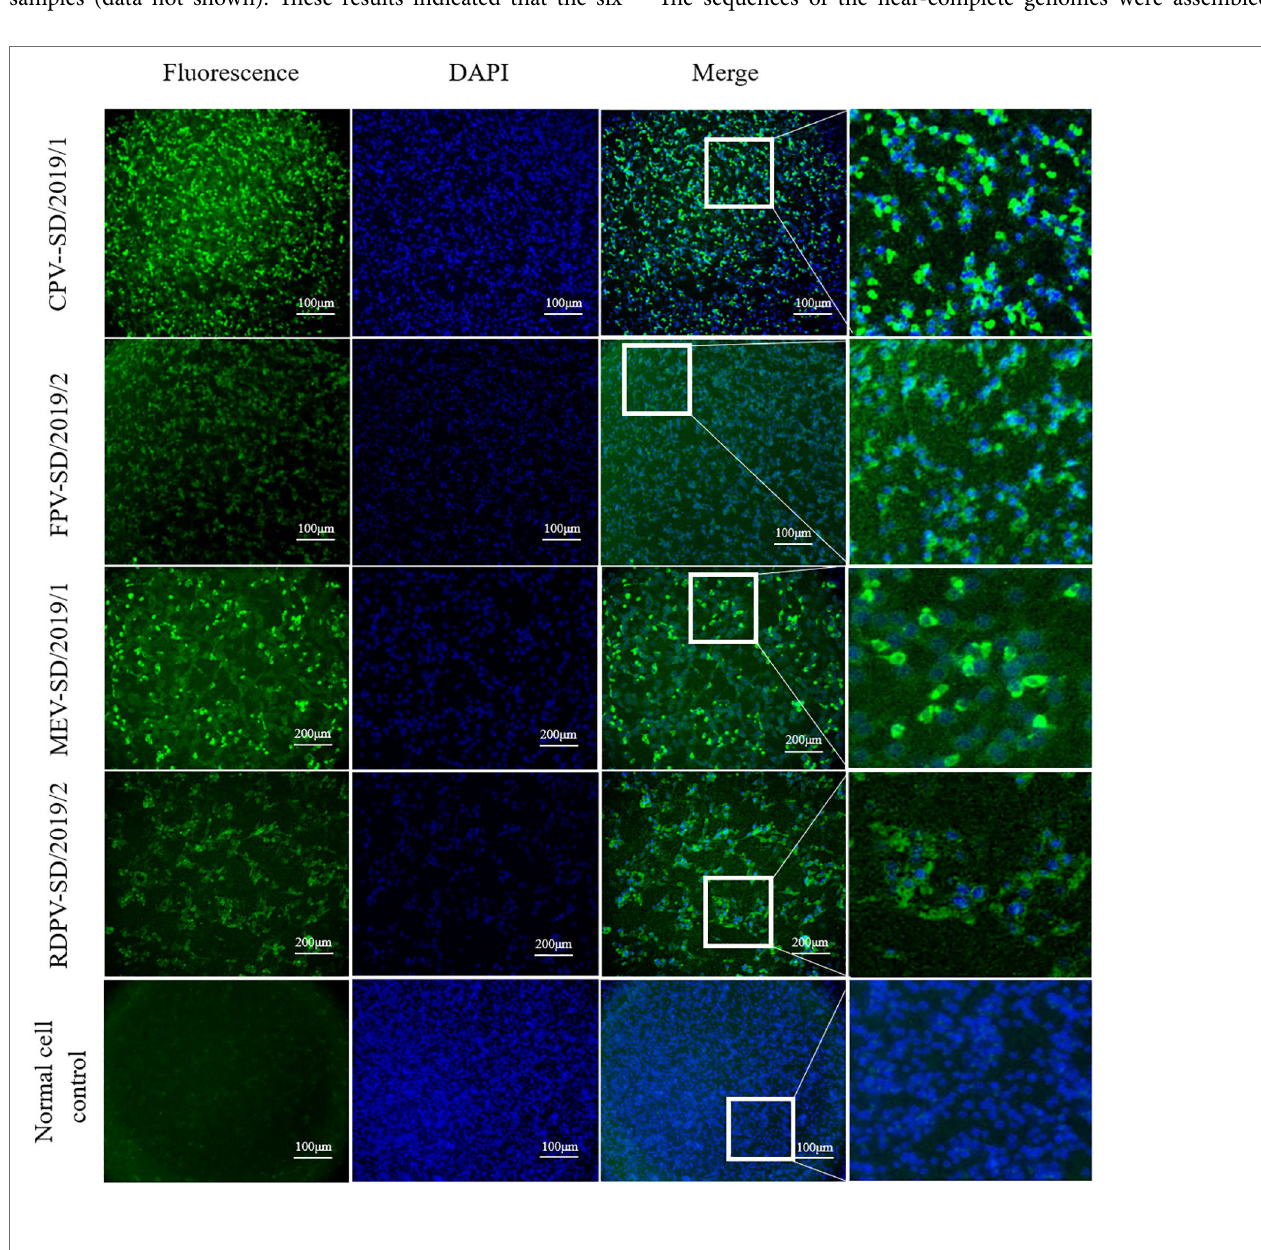
FIGURE 2 | Detection of feline panleukopenia virus (FPV), canine parvovirus (CPV), mink enteritis virus (MEV), and raccoon dog parvovirus (RDPV) in the infected F81 cells by indirect immunofluorescence assay with monoclonal antibodies against the viral particle 2 (VP2) protein of